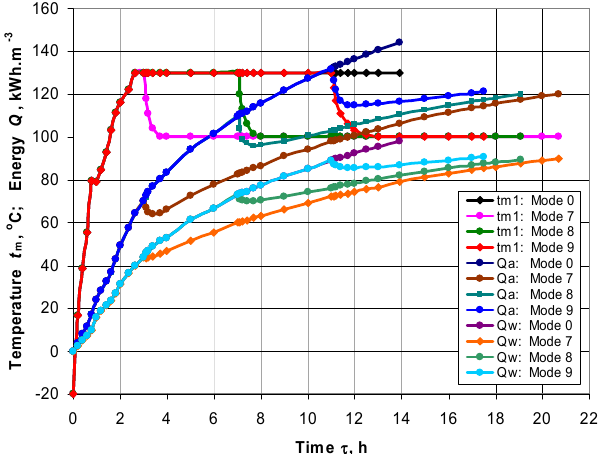
Figure 6. Changes in t m , Q a , and Q w during steaming modes 0, 7, 8, and 9, depending on τ . In Table 2, the change in τ 2 = τ steam , and τ 4 = τ mode (see Figure 2) of all modes, and also of the t w ‐ avg , Q w ‐ max , Q a ‐ max , and η is given. Figure 7 shows the change in Q w ‐‐ max and Q a ‐ max for all steaming modes.